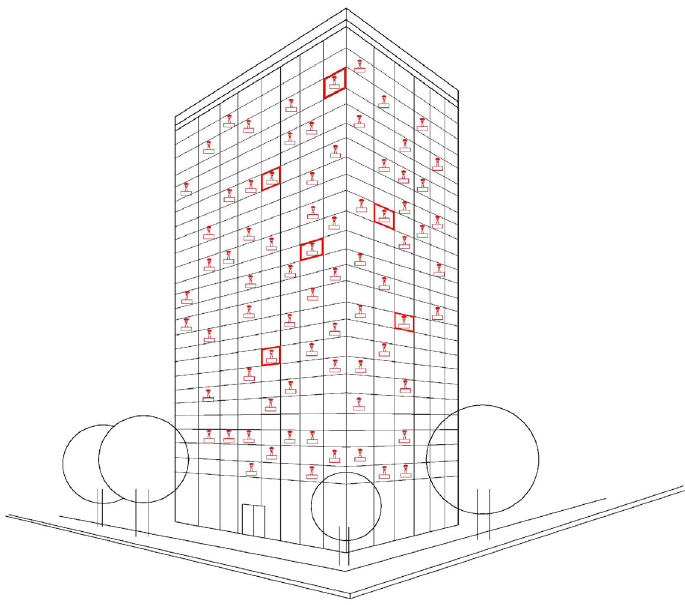
Figure 1. Nodes are distributed in a field within 200 × 200.